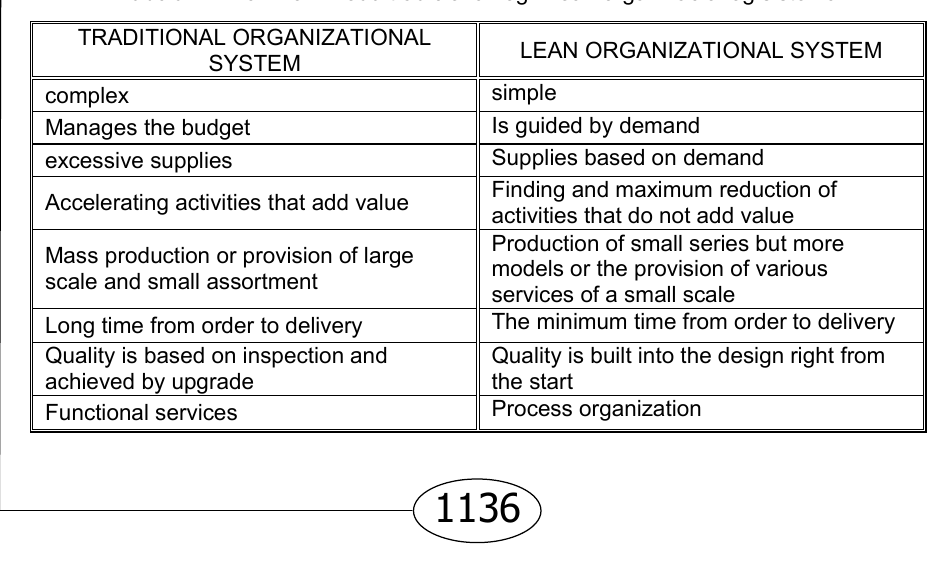
Table 1 – Difference between traditional and Lean organizational systems Таблица 1 – Отличия традиционной и Lean организационных